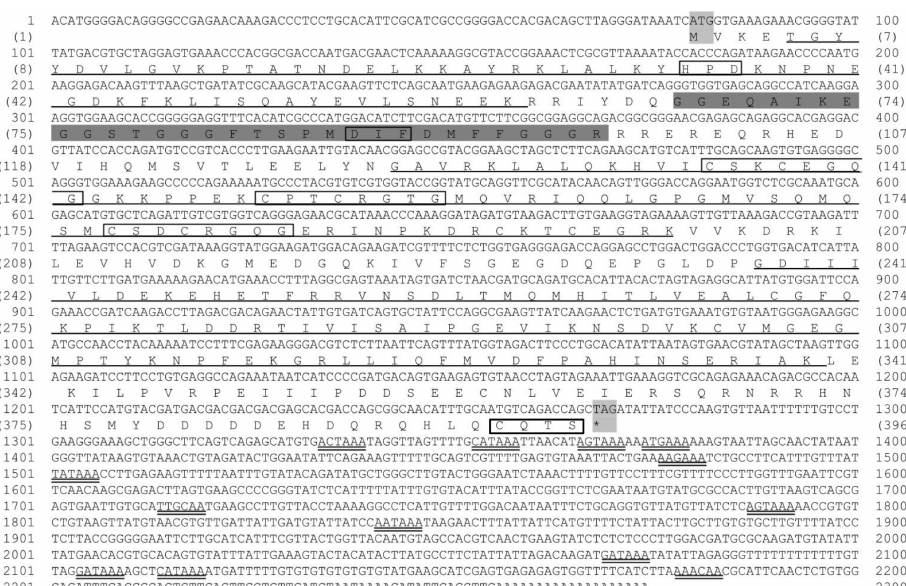
Figure 1. Nucleotide and deduced amino acid sequences of the Mr - hsp40 gene. All conserved amino acid motifs defining the hsp40 family signature (HPD, DIF and CXXCXGXG) and the consensus sequence CQTS at the C-terminus are shown in the open box. The N-terminal conserved domain (J domain), the central domain (CRR domain) and the C-terminal domain (CTD) are underlined. The glycine/phenylalanine-rich region (G/F) domain is highlighted by a gray background. N-linked glycosylation sites are shown by points. Polyadenylation signal sites are double underlined.